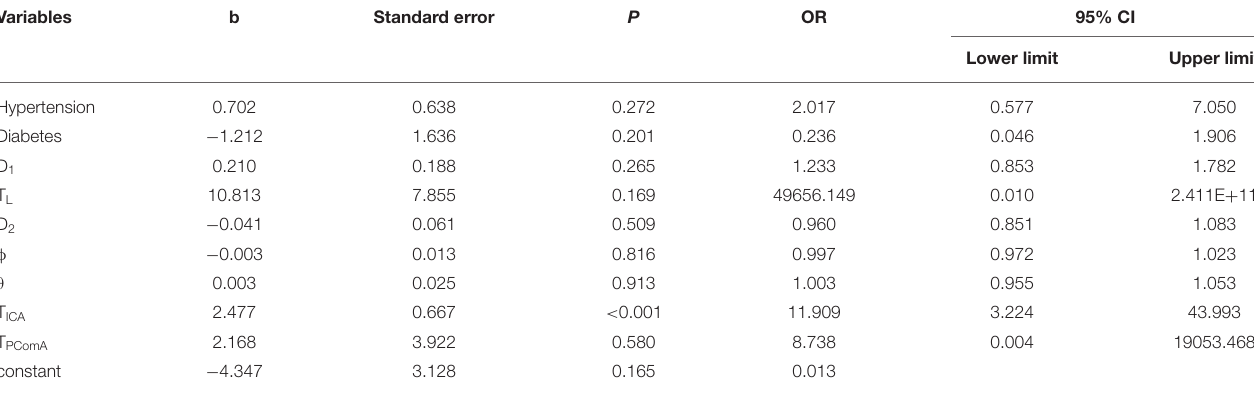
TABLE 5 | Binary logistic regression analysis of morphological parameters associated with PComA aneurysm presence. Variables b